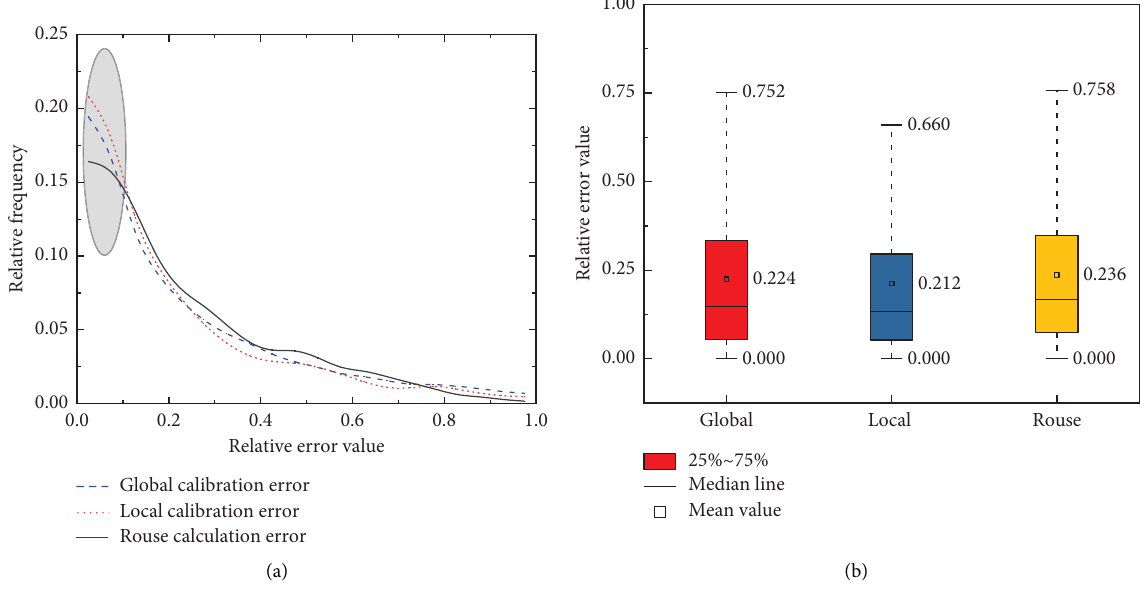
Figure 6: Calculation error of sediment concentration with diferent m values. Among them, (a) the probability distribution of the relative error of diferent m values, the black solid line represents the calculation result of the Rouse equation with m � 0, the red-dashed line represents the result calculated by equation (21) with m values (Table 1) determined at diferent water depths, and the blue-dotted line represents the result of equation (21) calculated with the global coefcient rate m � 0 . 34. (b) Boxplots of relative error distributions for diferent m